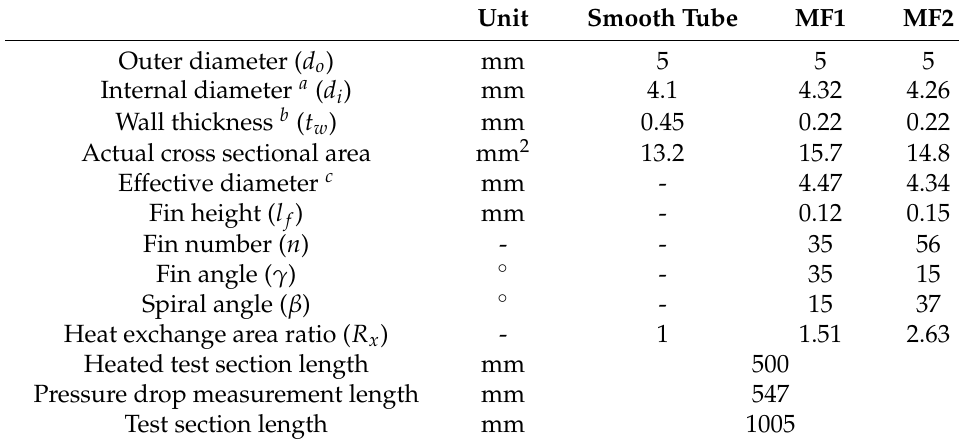
Table 1. Geometrical parameters of the test tubes.